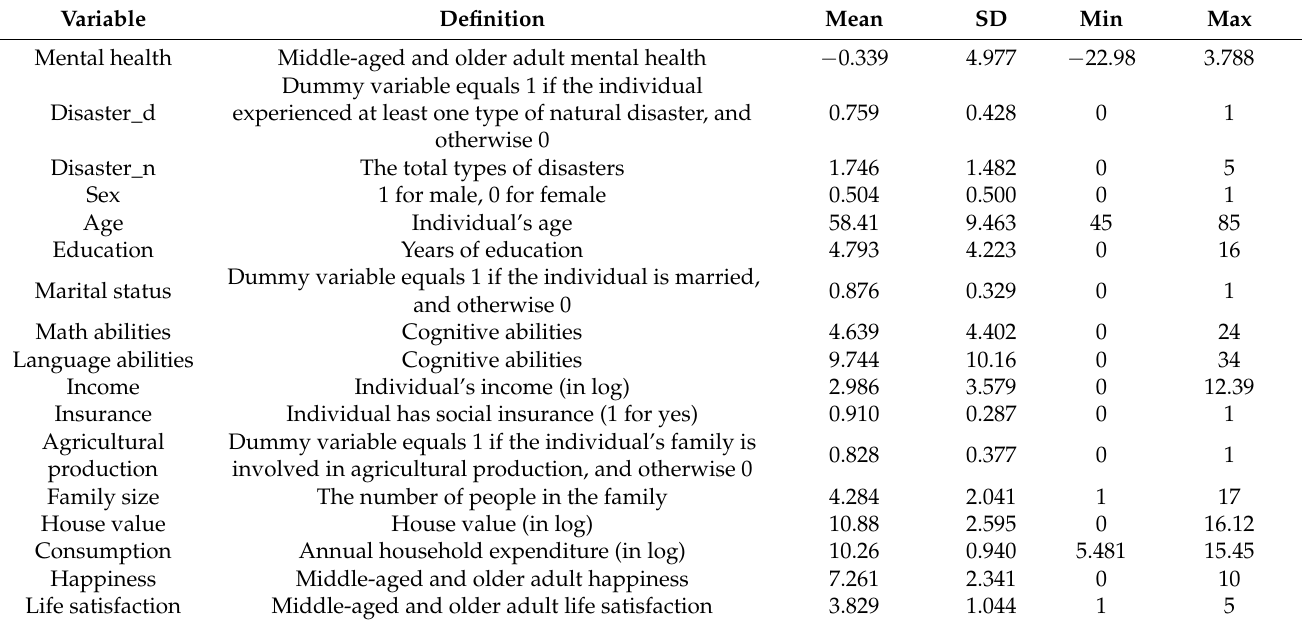
Table 1. Descriptive statistics of the key